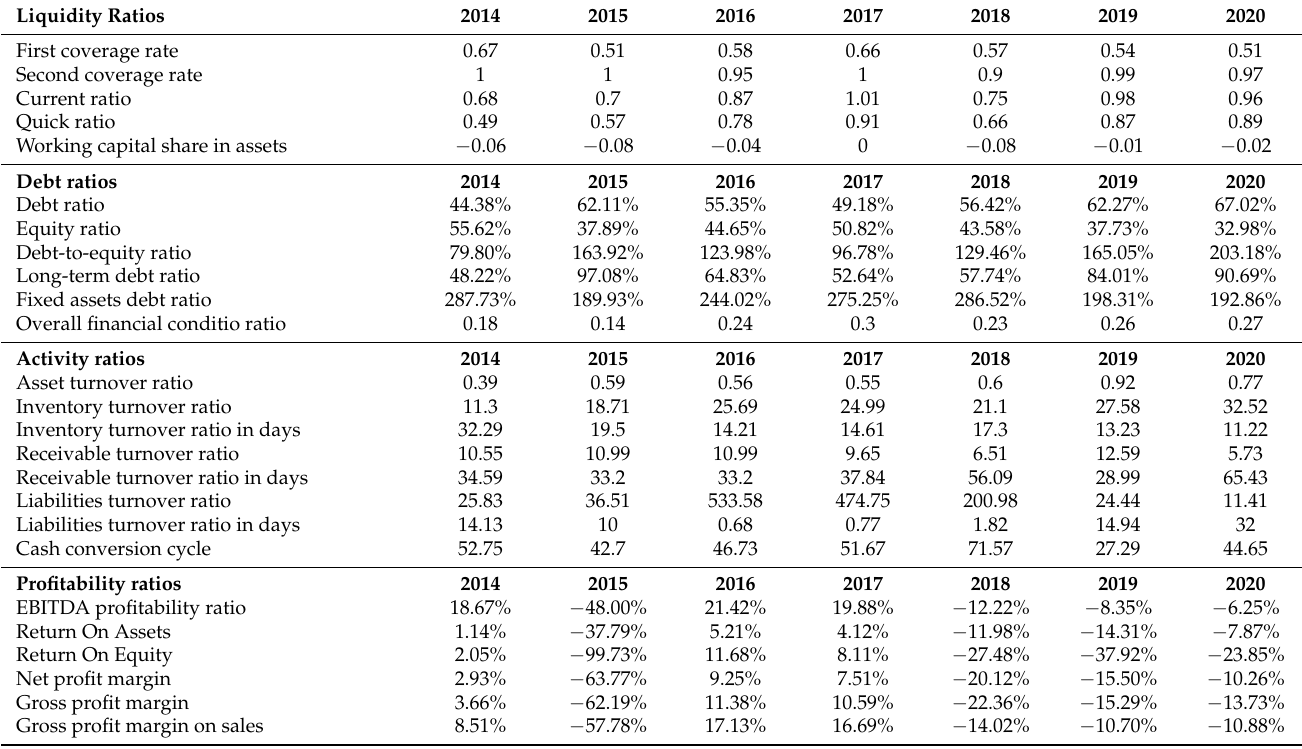
Table 16. Financial ratios of ZE PAK capital group in the years